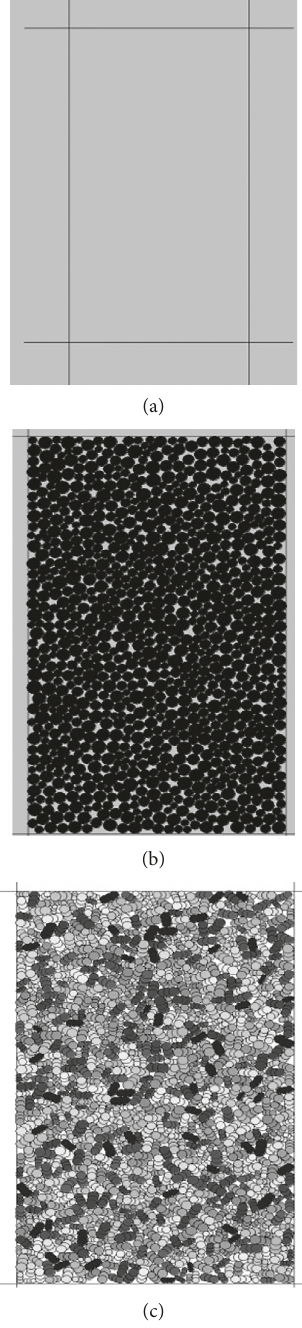
Figure 3: Process of generating numerical samples: (a) generating wall; (b) generating disc unit samples; (c) generating long unit